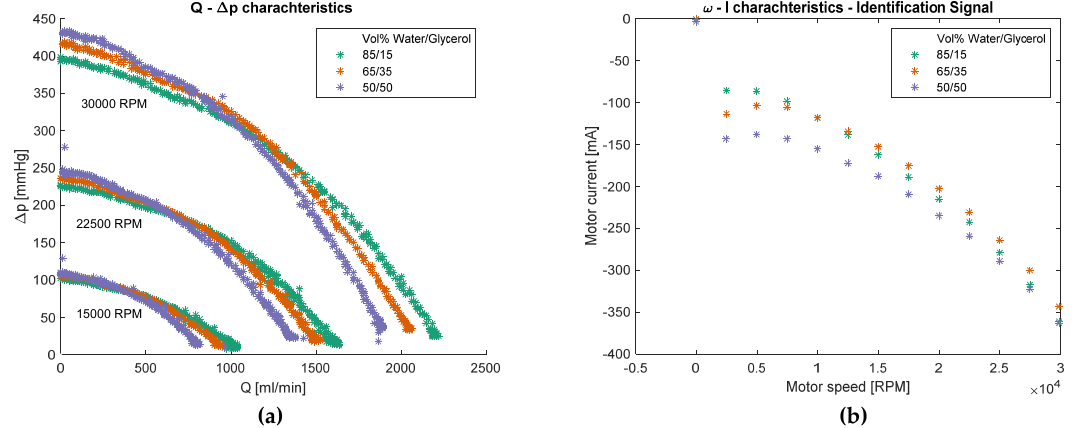
Figure 3. ( a ) Q– (cid:52) p characteristics of the motor-pump assembly used in the experiment. Three clusters Figure 3. (a) Q– △ p characteristics of the motor ‐ pump assembly used in the experiment. Three of curves can be seen corresponding to three di ff erent motor speeds, while the color coding refers to clusters of curves can be seen corresponding to three different motor speeds, while the color di ff erent viscosities of the test liquid; ( b ) ω –I characteristics of the motor - pump assembly. The motor coding refers to different viscosities of the test liquid; (b) ω –I characteristics of the motor ‐ pump current is plotted in a boxplot versus motor speed and viscosity of the test assembly. The motor current is plotted in a boxplot versus motor speed and viscosity of the test liquid.